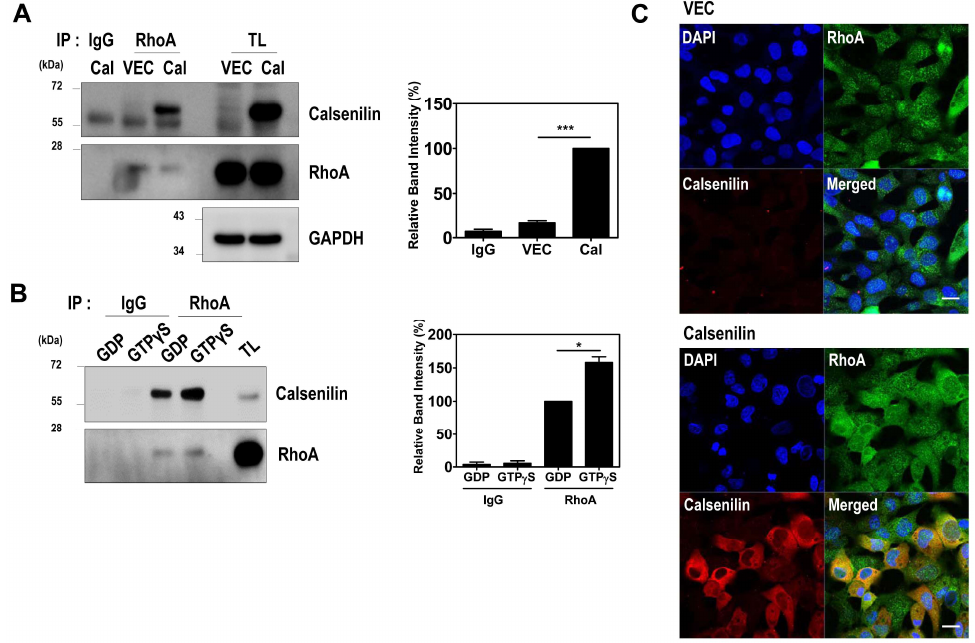
Figure 1. Calsenilin interacts with RhoA. ( A ) PC12 cells stably expressing either vector (VEC) or calsenilin (Cal) were immunoprecipitated with an anti-RhoA antibody and then analyzed by Western blotting with anti-calsenilin, and anti-RhoA antibodies; ( B ) Total cell lysates from PC12 cells expressing calsenilin were preloaded with GDP or GTP γ S, after which the proteins were immunoprecipitated with an anti-RhoA antibody and analyzed by Western blotting using anti-calsenilin and anti-RhoA antibodies. The intensities of the bands in each panel were measured and quantified for each group, and the values are expressed as the mean ± SEM of three independent experiments ( n = 3, * p < 0.05; *** p < 0.001); ( C ) The co-localization of calsenilin with RhoA in HEK293 cells expressing either vector (VEC) or calsenilin (Cal) was assessed by double immunofluorescence staining and confocal microscopy. VEC, pEGFP-N1 vector; Cal, GFP-tagged full-length of human calsenilin; TL, total cell lysates. Glyceraldehyde 3-phosphate dehydrogenase (GAPDH) was used as a loading control. DAPI (blue) was used to counterstain the nuclei. Scale bars, 20 μm.